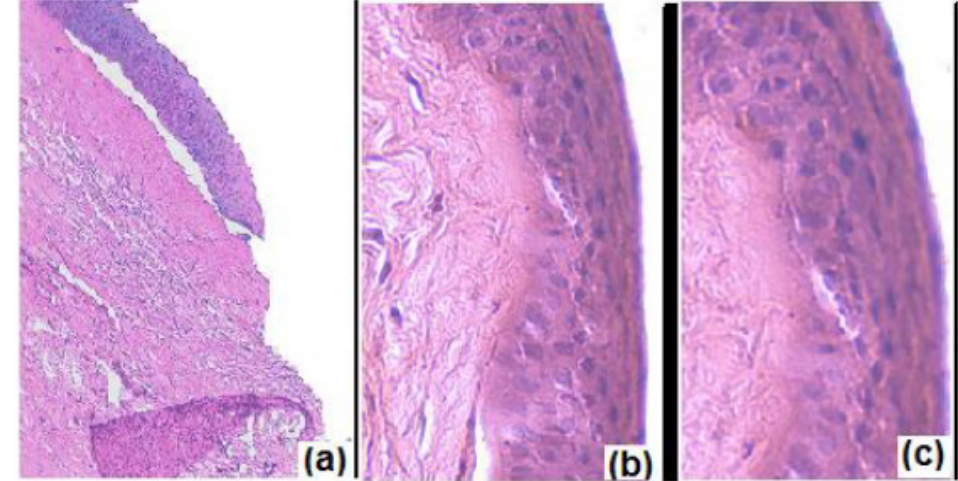
Figure 5. Histological cross-section of excised goat cornea stained with hematoxylin–eosin after treated with ( a ) isopropyl alcohol as the positive control; ( b ) normal saline as the negative control; and ( c ) a developed chitosan nanoparticulate in situ gelling system [68]. A noticeable difference comparing both developed formulations with positive control is the widening of intracellular spaces with the distortion of superficial epithelial cells, which highlights that the developed formulation was generally tolerable on the goat cornea.